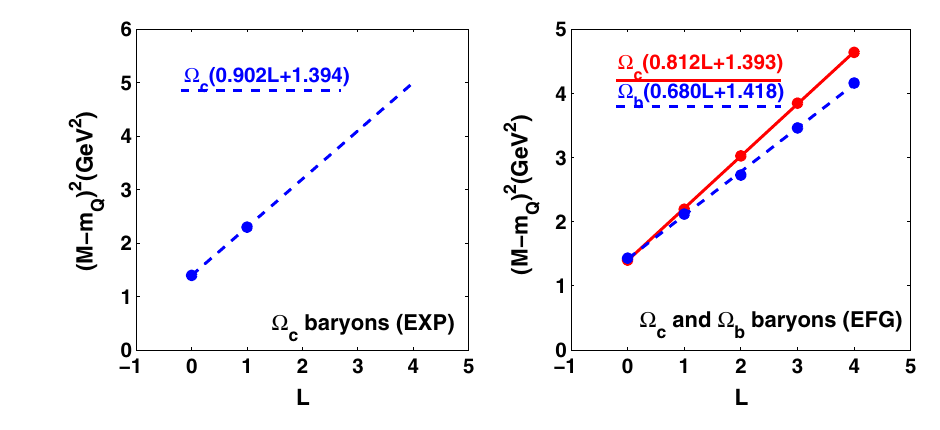
Fig. 7 Plots of experimental data for (cid:4) c baryons and model calculation results [18] of (cid:4) Q baryons. The best fit lines are given by the